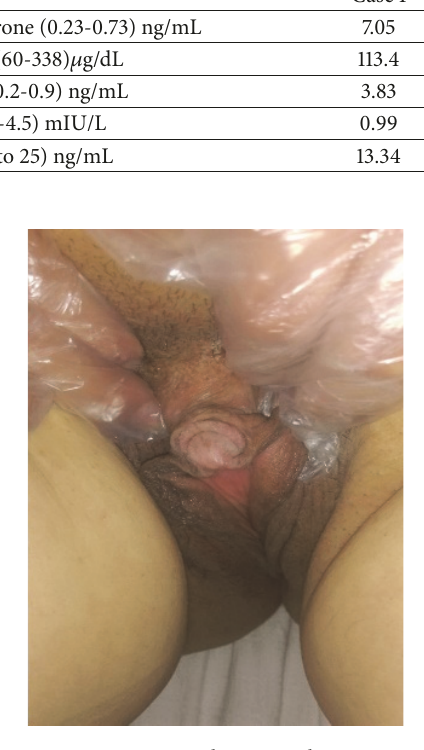
Figure 1: Clitoromegaly. Figure 2: On the top, the figure shows sagittal CT section of the left ovary measures 2.74 cm by 3.14 cm. On the bottom, it shows coronal section adrenals with the largest nodule in right adrenal gland measures 3.66 cm by 1.82 cm with a left adrenal